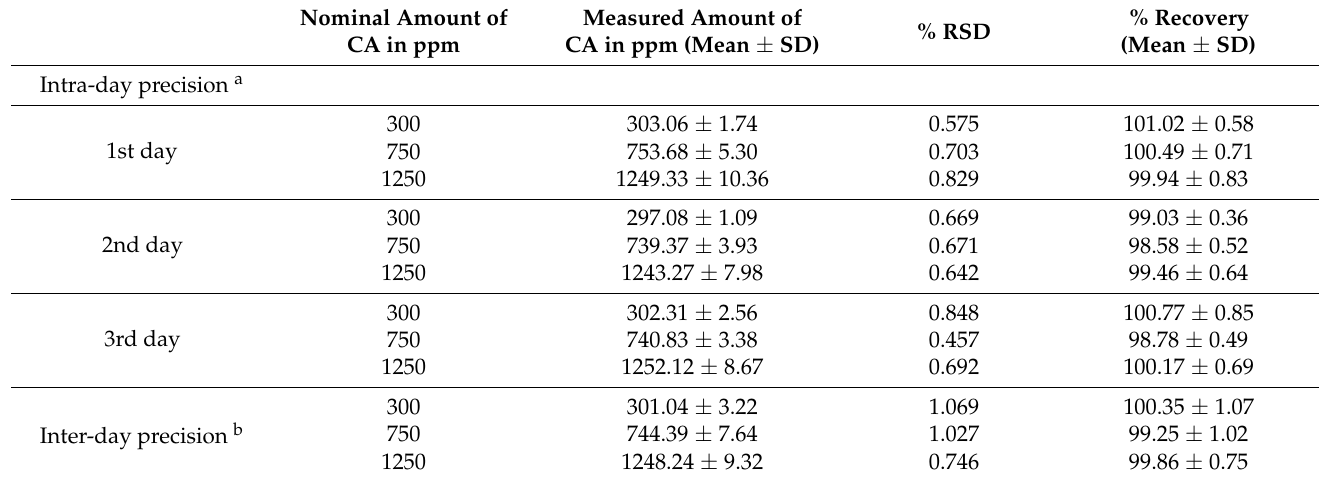
Table 3. Precision (intra- and inter-day) and accuracy of the method for determination of CA concentration in IVIG